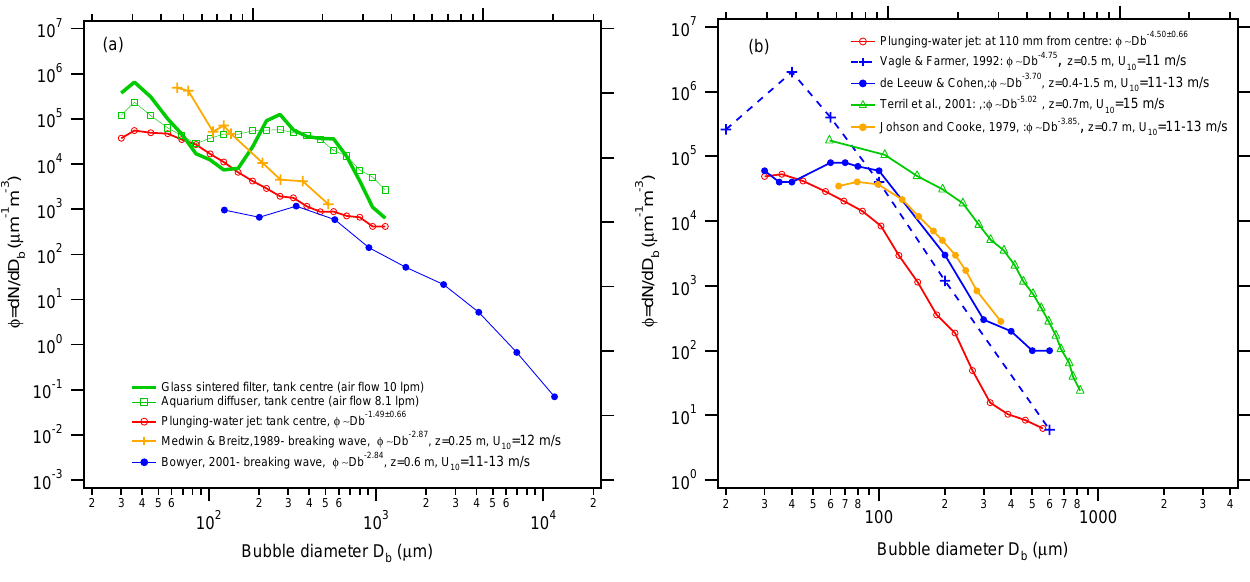
Fig. 4. Comparison between (a) bubble spectra obtained in the tank centre for the plunging-water jet system and spargers in this study and oceanic bubble spectra below breaking waves and (b) bubble spectra measurements at 110mm from the impingement point in the water jet system and quiescent oceanic bubble spectra. ( z =depth, U 10 =wind speed at 10m above the